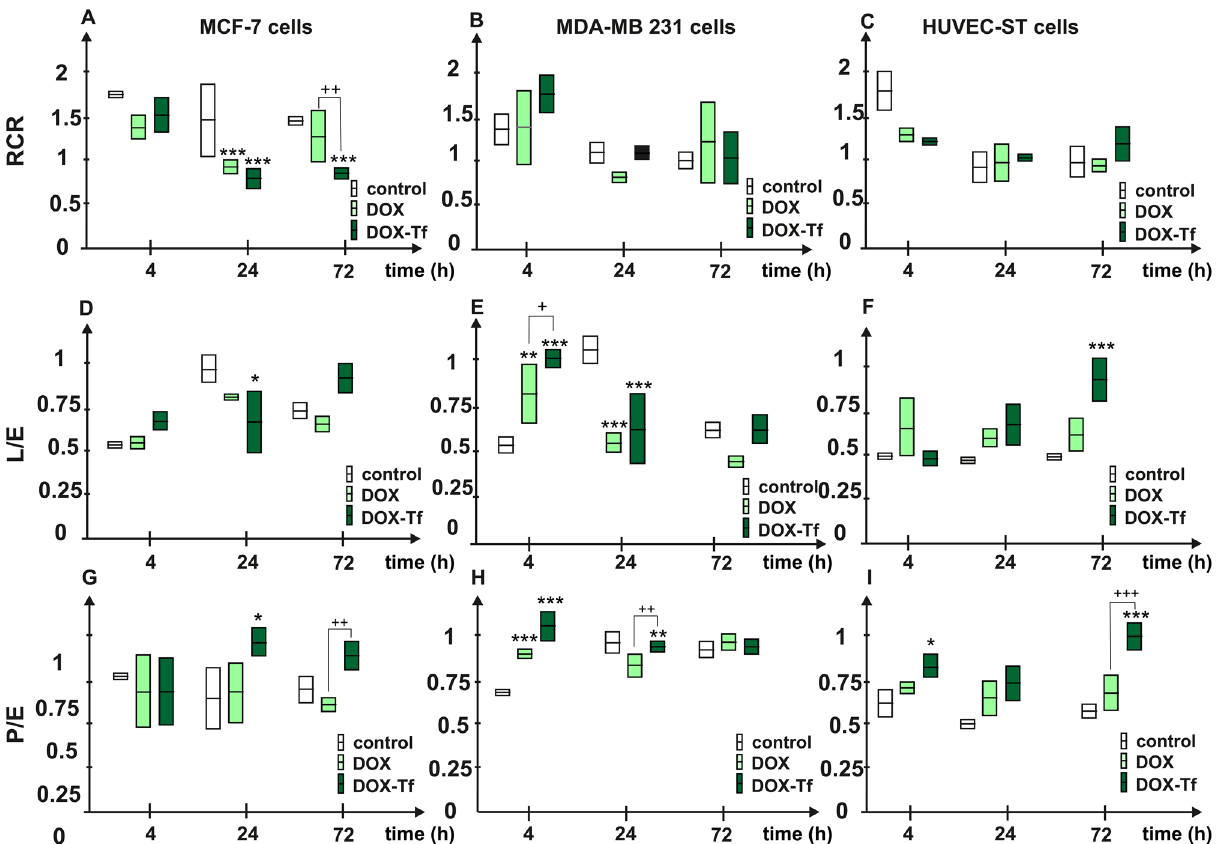
Figure 7. Selected parameters of mitochondrial bioenergetics in human breast cancer cell lines (MCF-7 and MDA-MB-231) and noncancer HUVEC-ST cells. The following mitochondrial parameters were evaluated: RCR (A–C) L/E, (D–F) and P/E (G–I). Measurement was performed after 4, 24 and 72 h incubation with DOX alone or DOX–Tf conjugate (IC 50 doses). Data are expressed as mean ± SD, n = 3, * p < 0.05, ** p < 0.01, *** p < 0.001 denote statistically significant changes in comparison with the control untreated cells; + p < 0.05, ++ p < 0.01, +++ p < 0.001 significant differences between samples incubated with DOX or DOX–Tf.